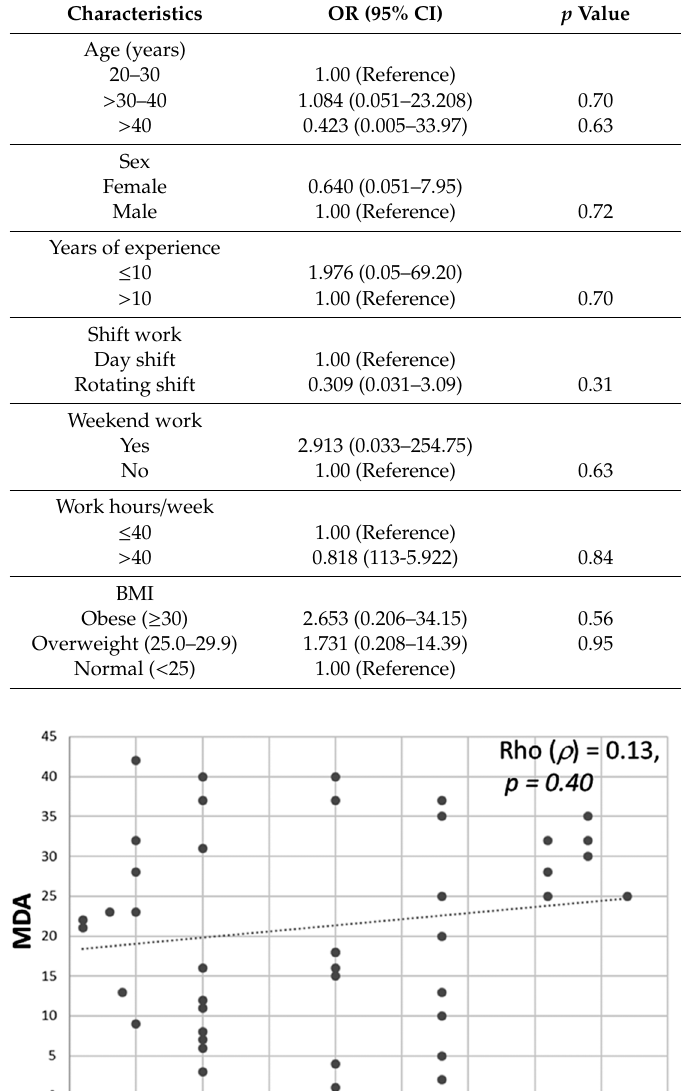
Table 6. Demographic and socioeconomic indicators as risk factors for high ERR.